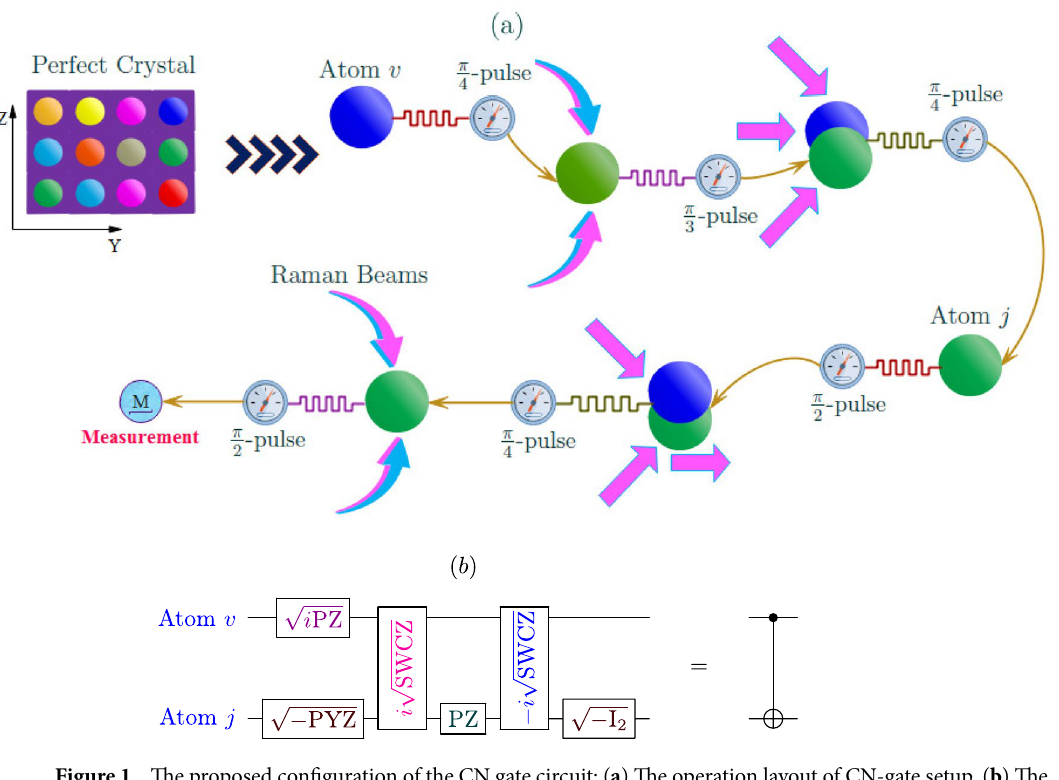
Figure 1. The proposed configuration of the CN gate circuit: ( a ) The operation layout of CN-gate setup. ( b ) The equivalent configuration of the CN circuit. CN circuits Refs. Required gates Required